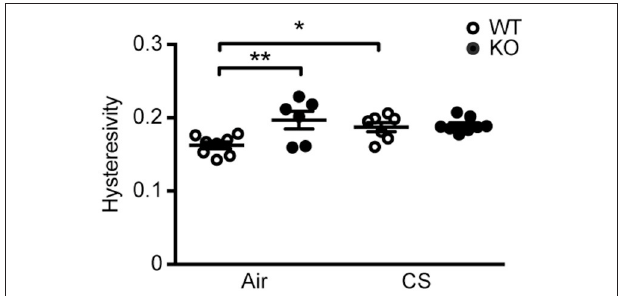
FIGURE 2 | SP-D deficiency and cigarette smoke (CS) exposure cause changes in pulmonary mechanics in mice. Changes in lung hysteresivity after 12 weeks of CS exposure. n = 6–8. * p < 0.05, ** p < 0.01, analyzed by one-way ANOVA followed by Bonferroni’s